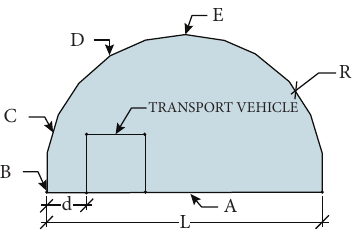
Figure 1: The separation of the tunnel cross-sections. A: the asphalt pavement; B-C: flames-continuous zone; C-D: the flame plume zone; E: the ceiling